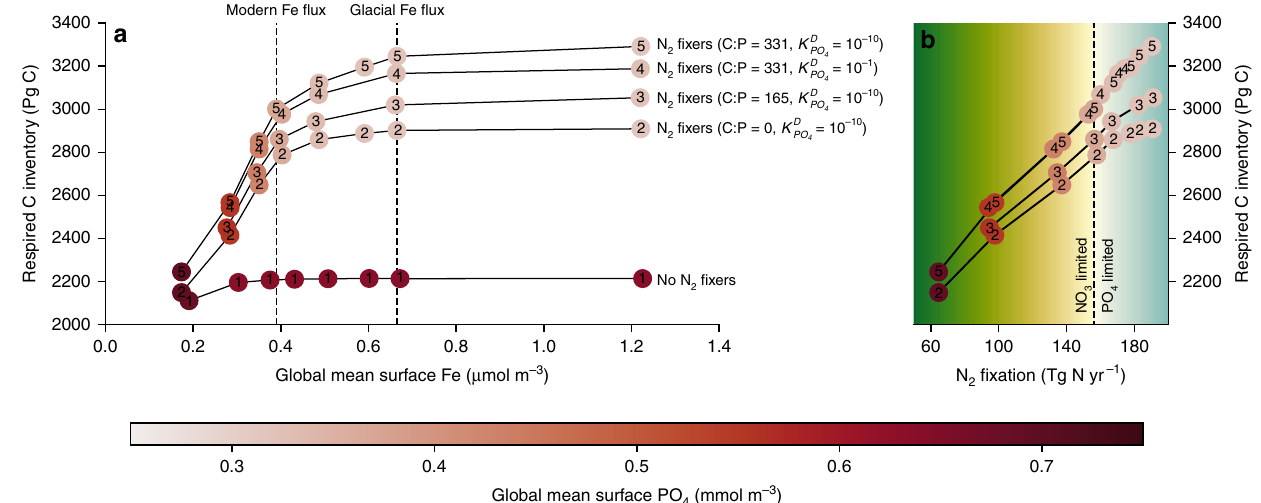
Fig. 3 How N 2 fi xation enables CO 2 storage in the ocean. The response of the respired C inventory to aeolian Fe deposition experiments for fi ve different representations of N 2 fi xers, with a demonstrating the relationship between respired C and Fe availability and b demonstrating the relationship between respired C and N 2 fi xation. The marker numbers refer to how N 2 fi xers are represented. Ones: no N 2 fi xers and no active N cycle. Twos: N 2 fi xers and N cycle (i.e., denitri fi cation) reinstated but no N 2 fi xer carbon export (C:P = 0:1). Threes: N 2 fi xers C:P ratio increased to 165:1, half its default value. Fours: N 2 fi xers PO fi cient K D 4 limitation enforced by increasing their half saturation coef PO 4 parameterisation. Colour shading of the markers indicates the mean surface PO 4 concentration of the experiment. Background shading in b is a qualitative indicator of the transition from NO 3 to PO 4 limitation, where dark green to yellow indicates NO 3 limitation and light blue indicates PO 4 limitation. Source data are provided in the source data fi